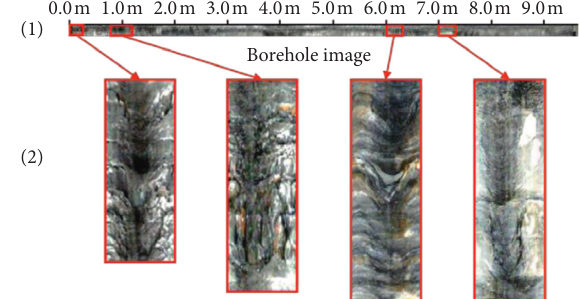
Figure 11: Borehole imaging of borehole #4 at station #1 under the influence of excavation,:(1) the 2D view of the borehole from 0 to 360 ° ; (2) the zoomed-in views of selected sections.